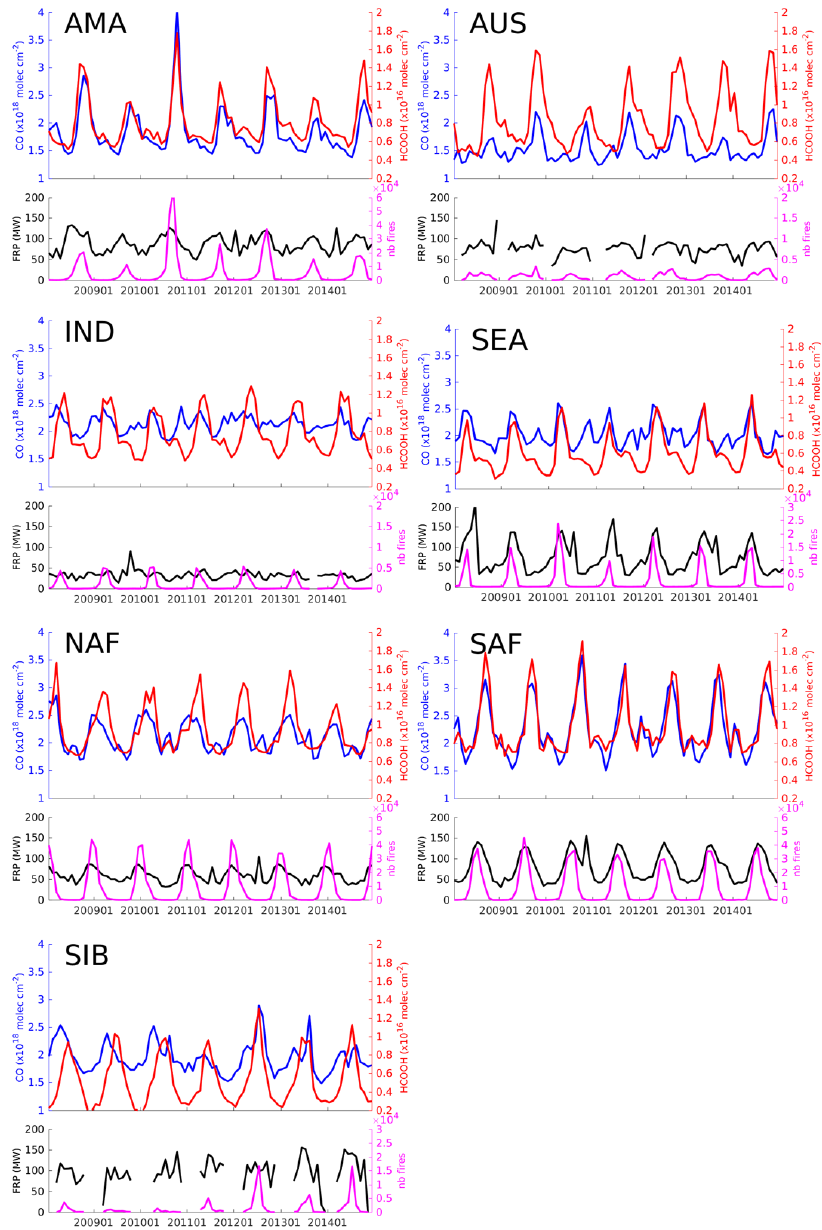
Figure 2. Time series from 2008 to 2014 of the monthly means of IASI CO (blue) and HCOOH (red) total columns in 10 18 moleccm − 2 and in 10 16 moleccm − 2 , respectively; FRP (black) in megawatts (MW); and the number of fires (nb fires, magenta) from MODIS over the seven regions (AMA, Amazonia; AUS, Australia; IND, India; SEA, Southeast Asia; NAF, northern Africa; SAF, southern Africa; SIB,